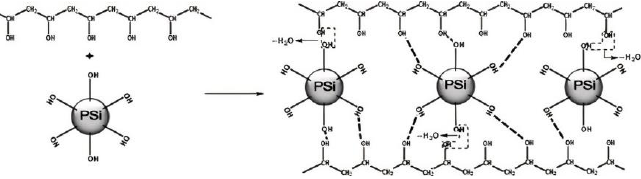
Figure 7. Structure and property of polyvinyl alcohol/precipitated silica composite hydrogels for microorganism immobilization.